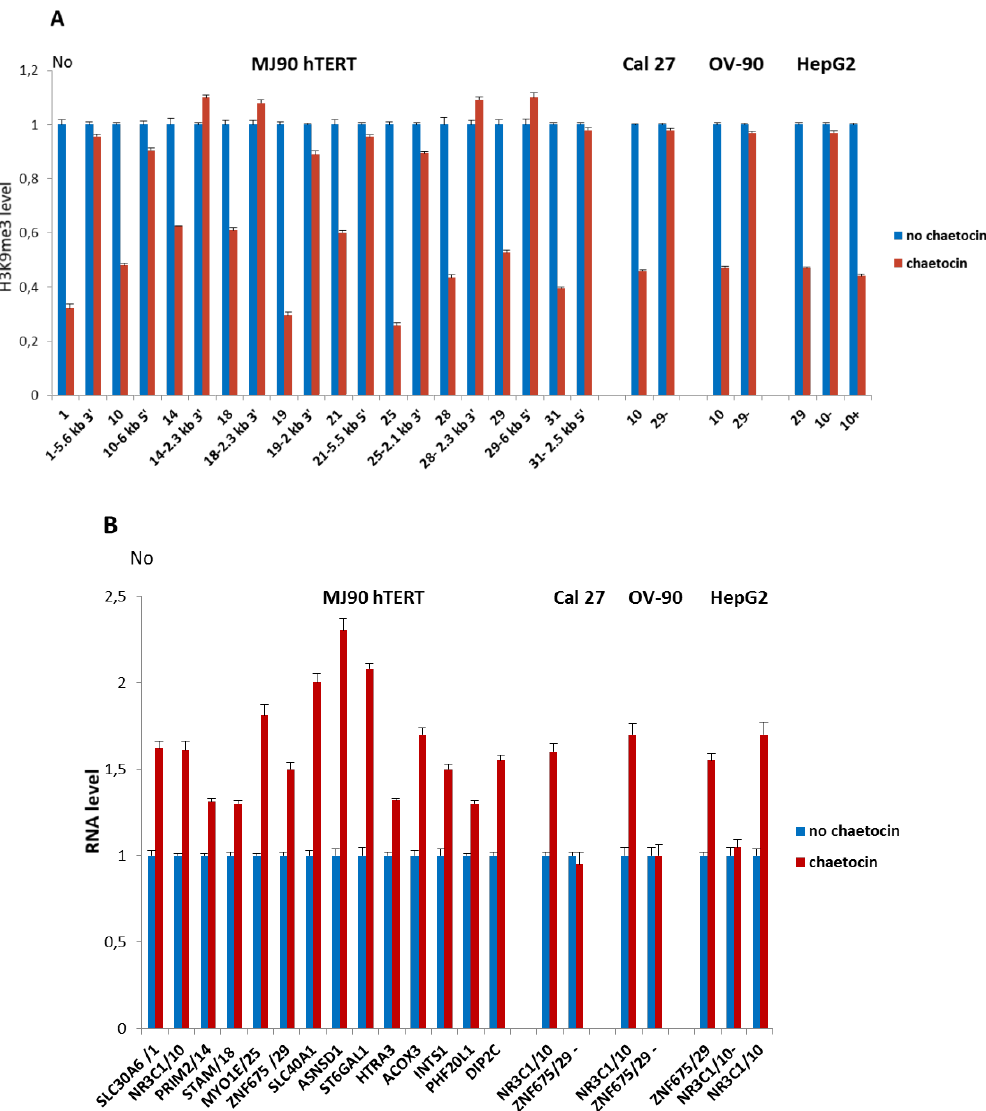
Figure 4. A ) The level of H3K9me3 at alpha satellite repeats and their neighboring regions after HS in the presence of chaetocin, inhibitor of histone methyltransferase Suv39H1. H3K9me3 level at intronic alpha satellite repeats No 1, 10, 14, 18, 19, 25, 21, 28, 29, 31 and at the regions positioned 2–6 kb